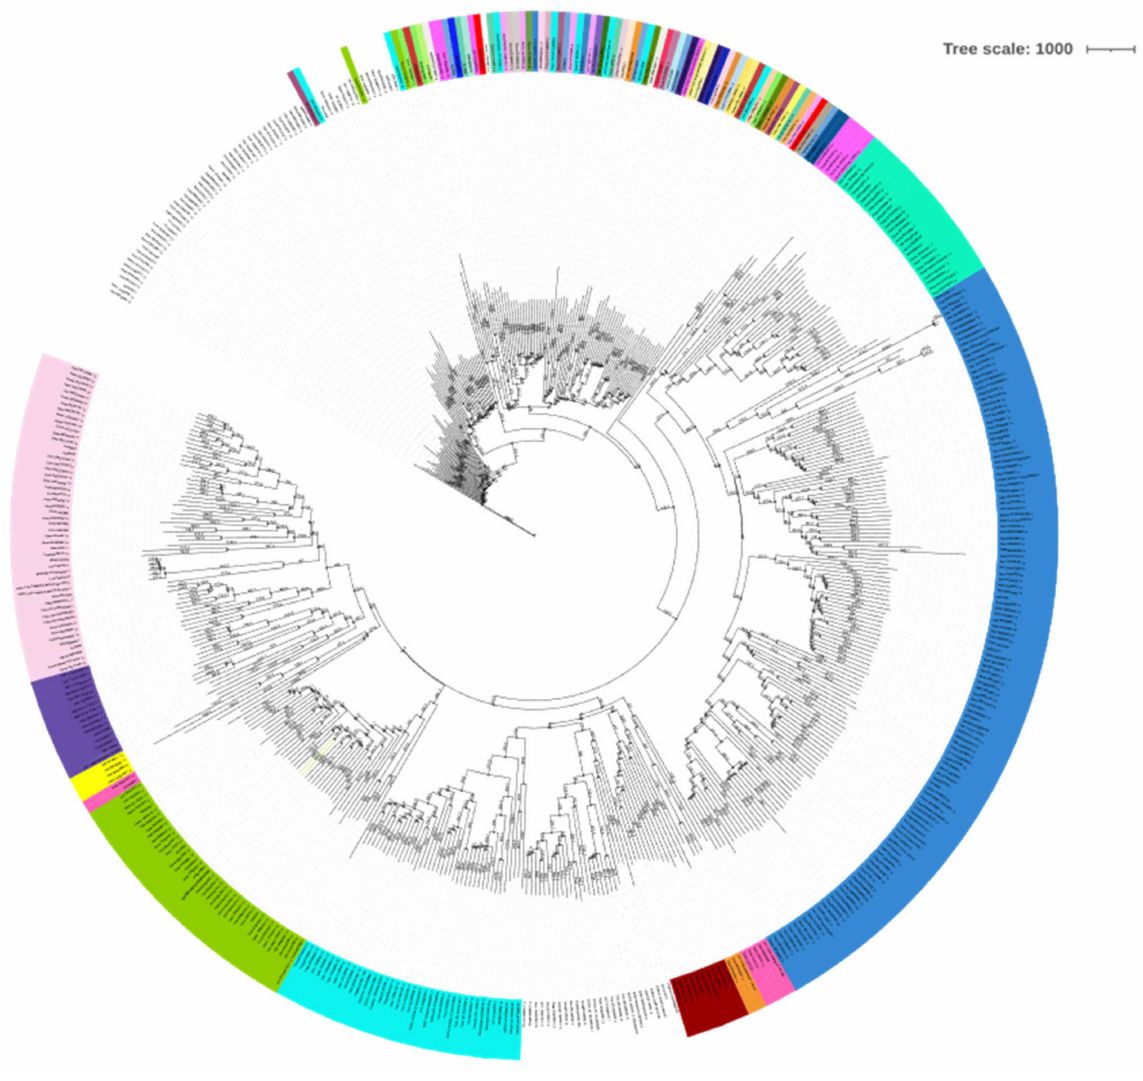
Figure 2. Phylogenetic analysis of BBM. Protein sequences were aligned by Clustal W, and the mid- point rooted phylogenetic tree was constructed using iTOL by the Neighborhood Joining (NJ) method. Based on the phylogenetic relationships, different subgroups were marked with different